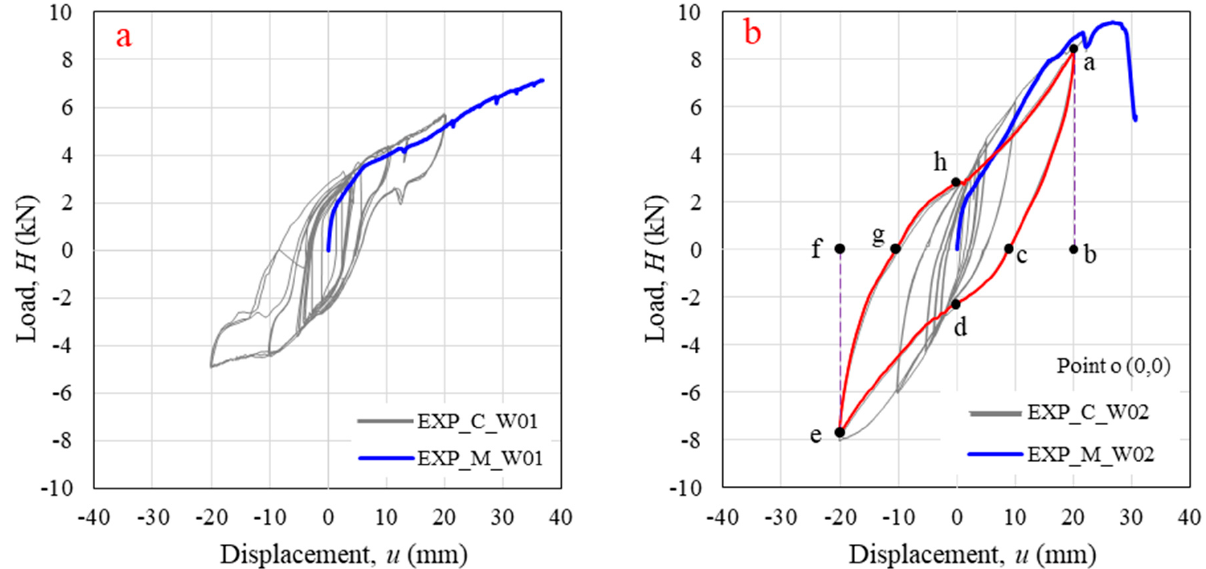
Figure 6. Horizontal in-plane lateral load versus displacement relationship (at DT A) under monotonic (EXP_M) and cyclic (EXP_C) loading for ( a ) Specimen W01; ( b ) Specimen W02.